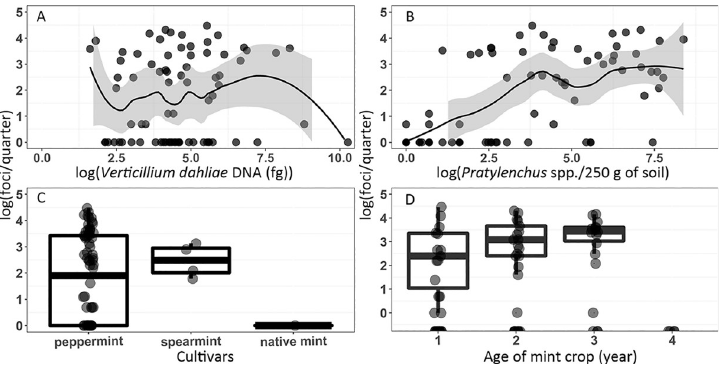
Fig 3. Wilt symptoms as a function of biotic and abiotic predictors. Verticillium wilt symptoms are presented as a function of (A) inoculum of Verticillium dahliae , (B) counts of Pratylenchus spp., (C) mint cultivars, and (D) age of mint